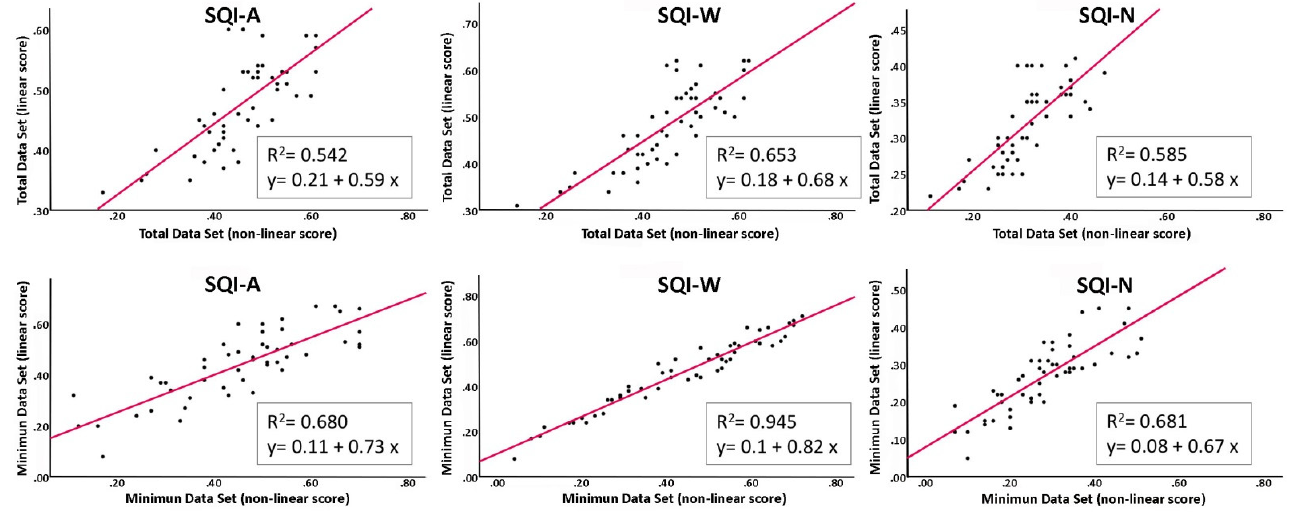
Figure 7. Linear relationships between the SQI-A, SQI-W and SQI-N models are calculated using the linear and nonlinear scoring functions, between the TDS (first line) and MDS (second line) methods. The highest coefficient (R = 0.95) has resulted when using the MDS-L-W and MDS- NL-W models (weighted additive models and linear and nonlinear scores,